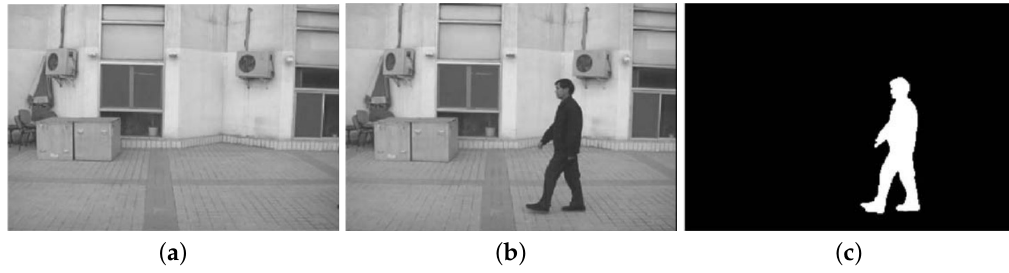
Figure 3. Examples of Silhouette Extraction in [227]. ( a ) The background image; ( b ) An original image; ( c ) The extracted silhouette from ( b ).